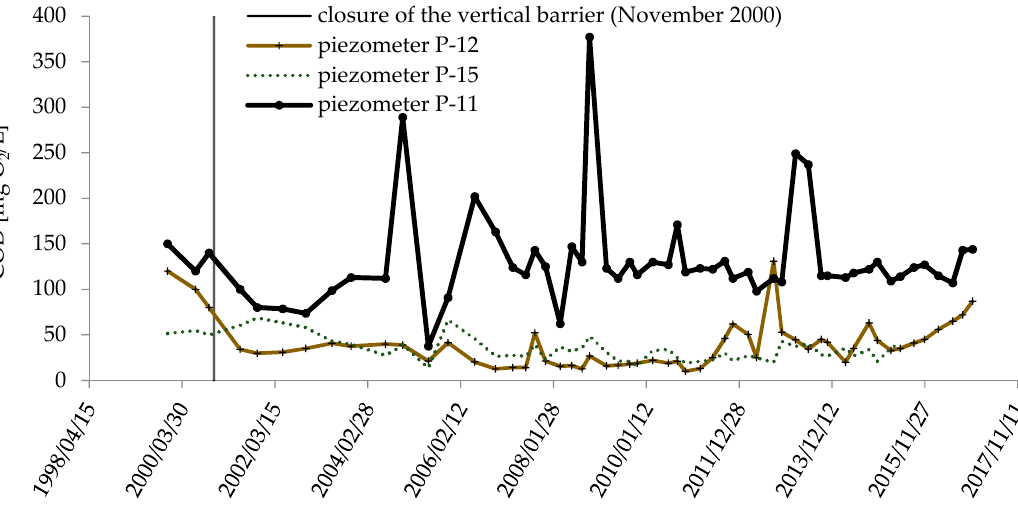
Figure 9. Temporal changes of the COD level in piezometers located in the area of composting plant.